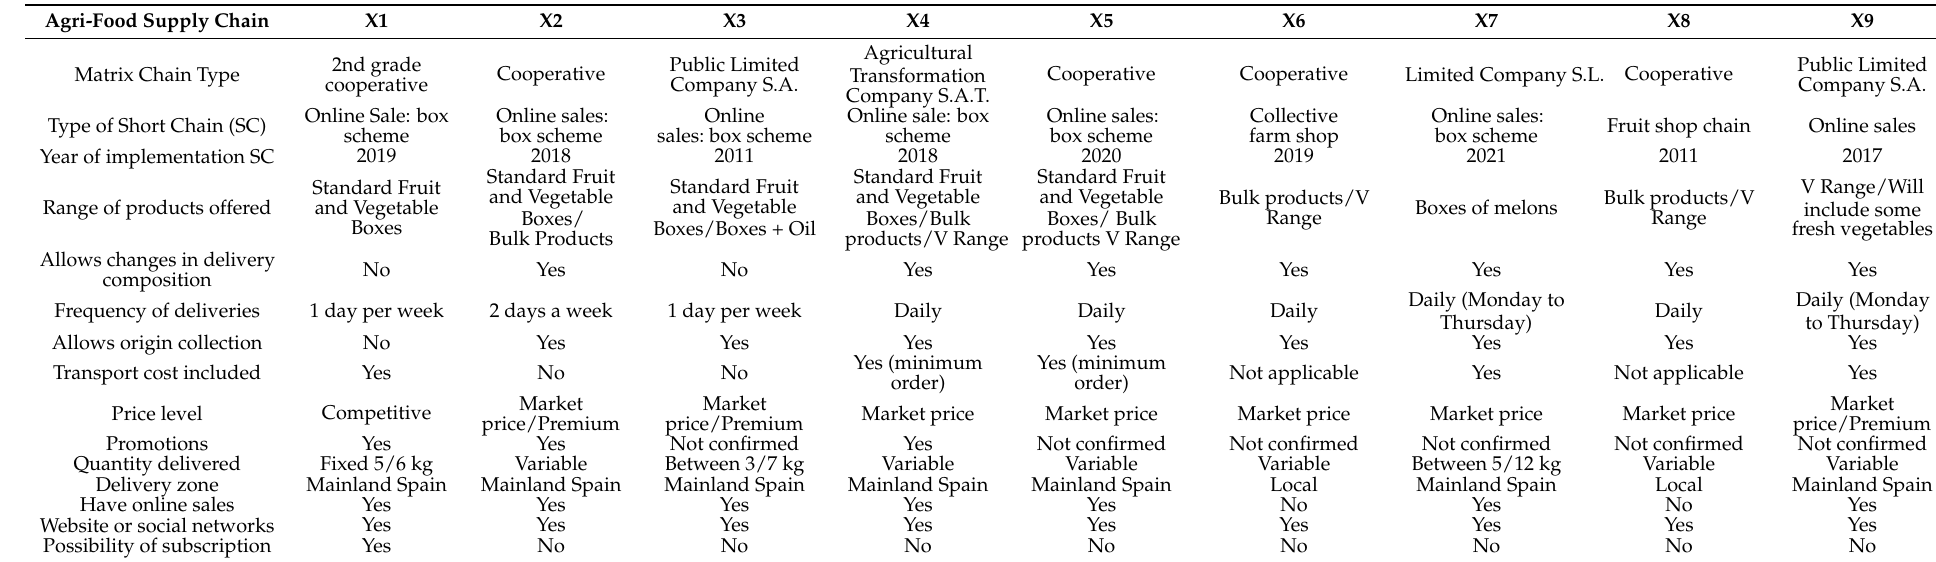
Table 1. Hybrid Agri-food Chains in Southeast Spain. Source: own